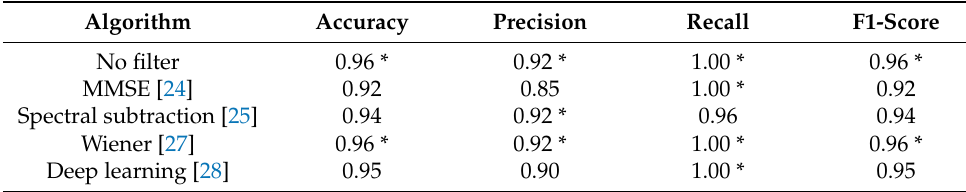
Table 5. Babble Noise SNR 10. * is the best result for each particular measure.